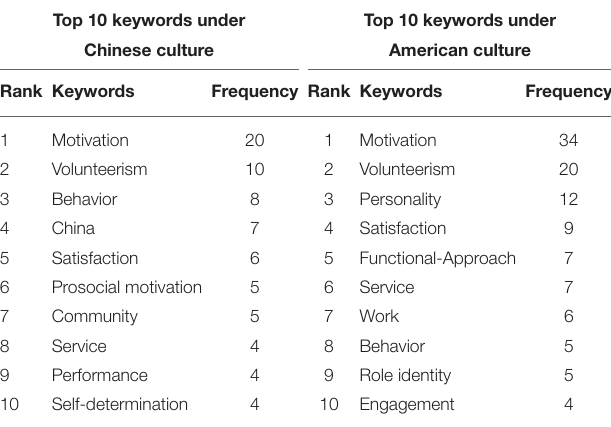
TABLE 10 | High-frequency keywords in different cultural